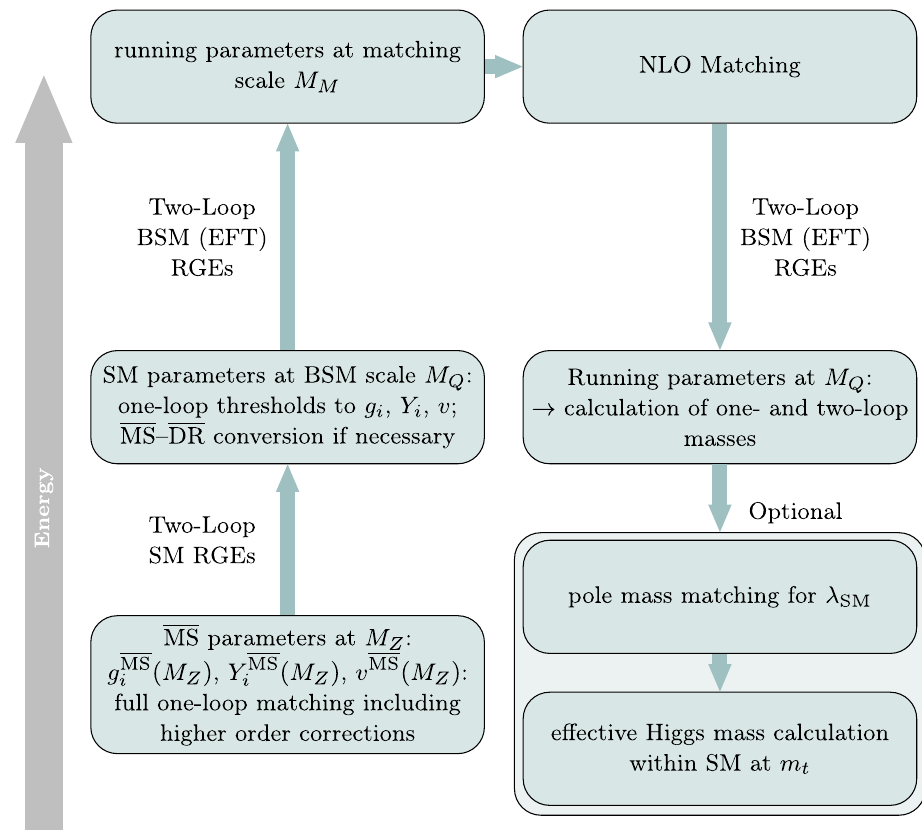
Fig. 5 Schematic procedure of the numerical evaluation of a parameter point with SPheno when using the analytical setup to calculate matching conditions and implement them in